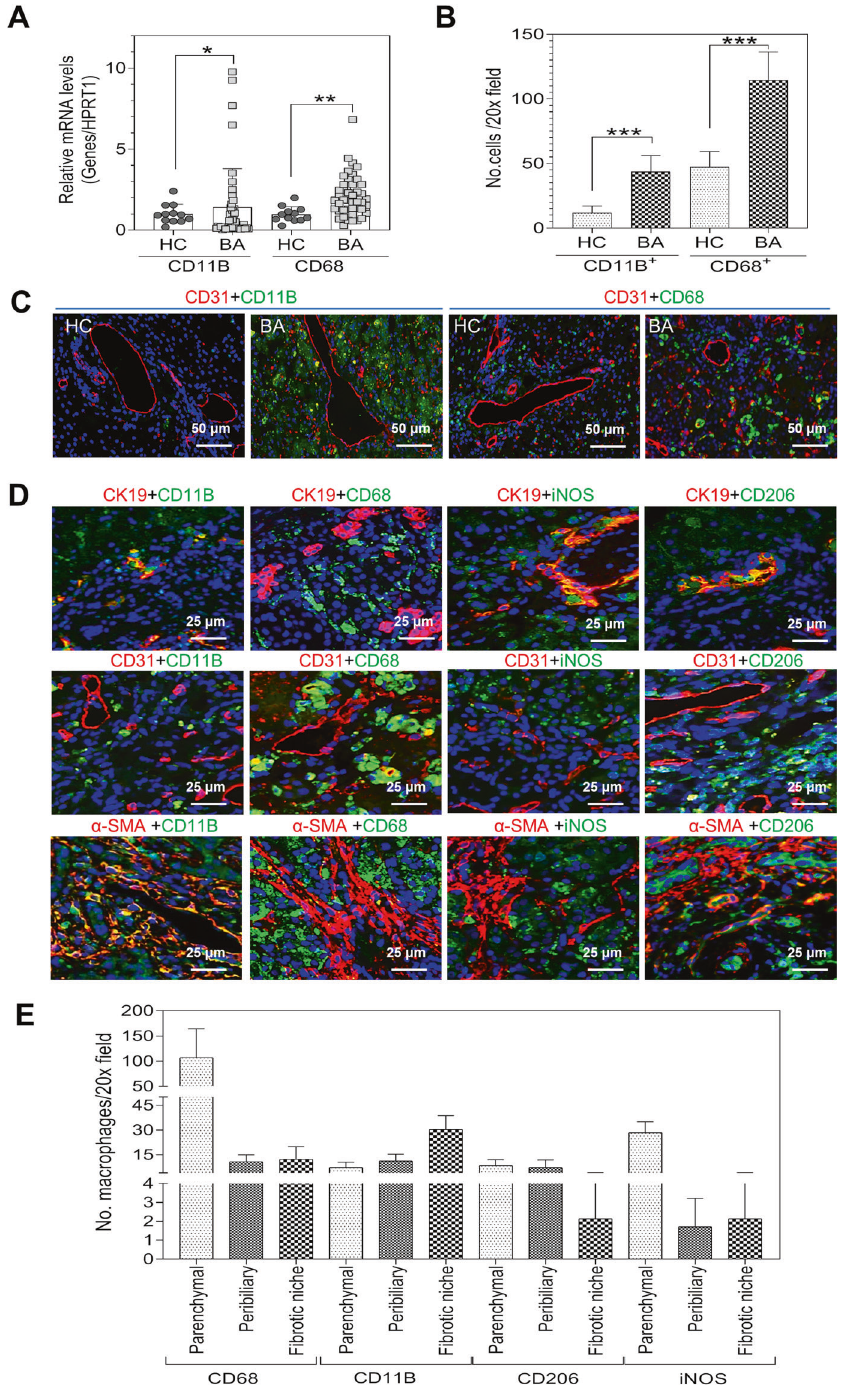
Fig. 1 Increased macrophages accumulate in fi brotic niche and peribiliary areas of BA patients ’ livers. A Relative mRNA levels of CD11B and CD68 in livers of BA patients ( n = 44) and controls ( n = 12) were determined by real-time PCR (RT-PCR). HPRT1 was used as an internal control. B Quanti fi cation of CD68 + and CD11B + cells in liver sections of HC ( n = 3) and BA ( n = 5) by ImageJ. C Representative images of co- immuno fl uorescence of CD31 and CD68, CD31 and CD11B in livers of BA and HC. Scale bars: 50 μ m. D Representative IF images of CK19, CD31, α -SMA, CD68, CD11B, CD206, and iNOS in BA patients ( n = 6). Scale bars: 25 μ m. E Graph of CD68, CD11B, CD206, and iNOS + macrophages in BA patients were determined by ImageJ. Data were expressed as mean ± SD. Statistical signi fi cance relative to controls: * P < 0.05; ** P < 0.01; *** P < 0.001. BA biliary atresia, HC healthy controls, HPRT1 hypoxanthine phosphoribosyl transferase